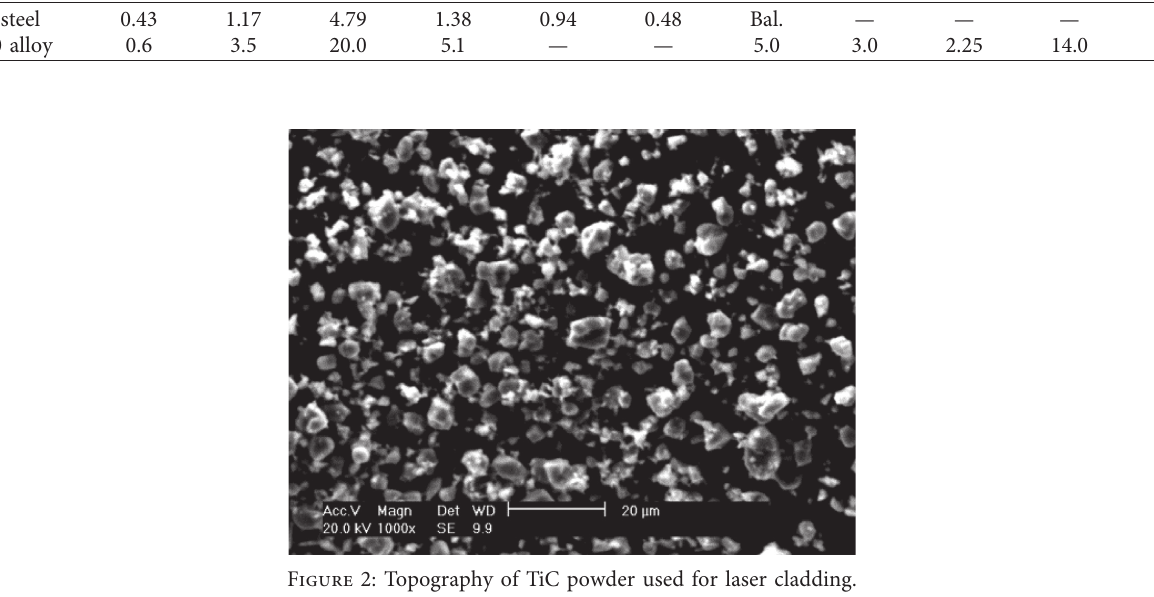
Table 1: Chemical composition of H13 steel and Co50 alloy powder used in experiments (% by weight). Element